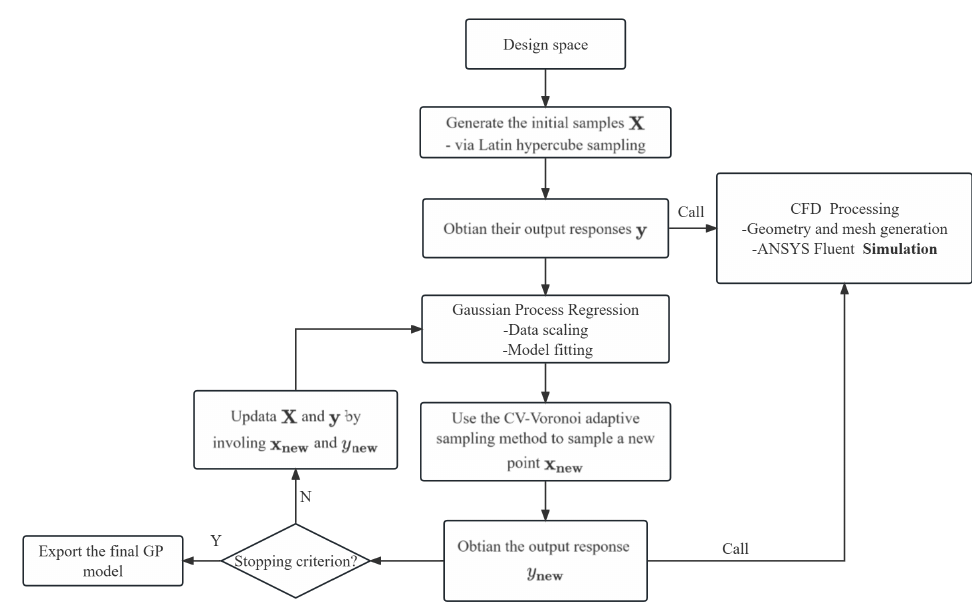
Figure 4. The flowchart of GP surrogating modeling via adaptive